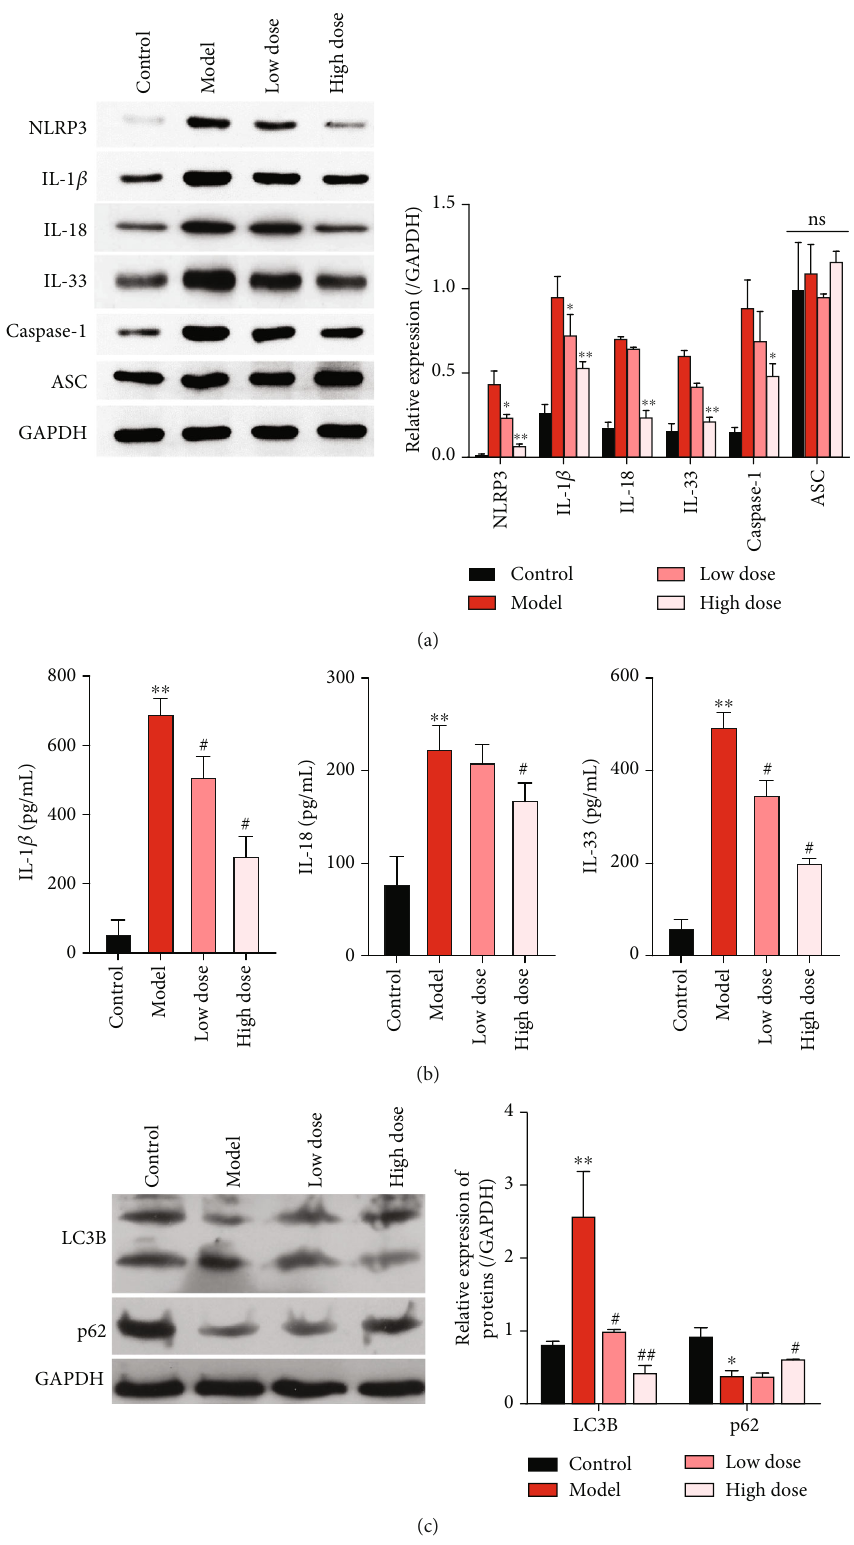
Figure 3: Xi Lei San prevented the activation of NLRP3 in fl ammasomes and autophagy in rats with DSS-induced colitis. (a) The DSS model rats with ulcerative colitis were treated with low or high doses of Xi Lei San. NLRP3, IL-1 β , caspase-1, and ASC expression determined by western blotting. GAPDH served an internal reference protein. (b) ELISA kits were used to analyze the concentrations of IL-1 β , IL-18, and IL-33 in each group. (c) Autophagy-related proteins, LC3B and p62, were measured by western blotting. ∗ P < 0 : 05 and ∗∗ P < 0 : 01 vs. the control group; # P < 0 : 05 and ## P < 0 : 01 vs. the model